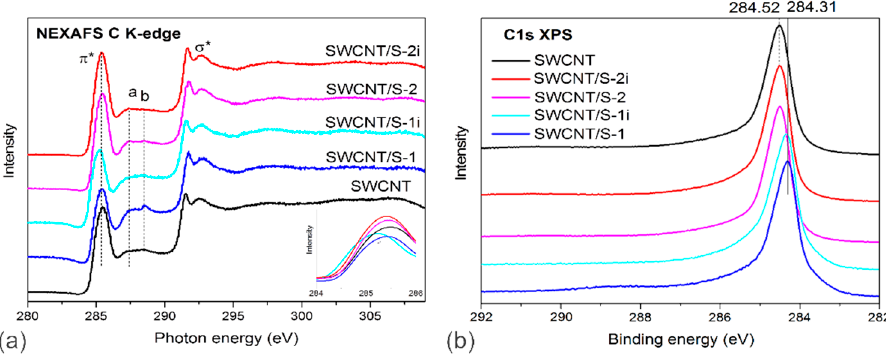
Figure 4. C K -edge NEXAFS ( a ) and C 1 s XPS ( b ) spectra of initial SWCNTs and sulfur-contained SWCNTs before and after illumination. The insert in ( a ) compares π * resonances of the spectra normalized to the intensity of σ * resonances.